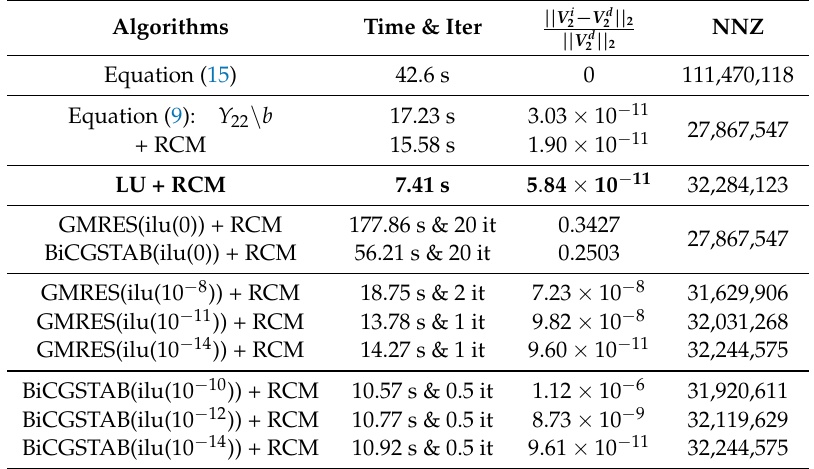
Table 5. Comparison between numerous NA techniques on the LLPF problem with complex components Equation (9). The best result is highlighted in the bold